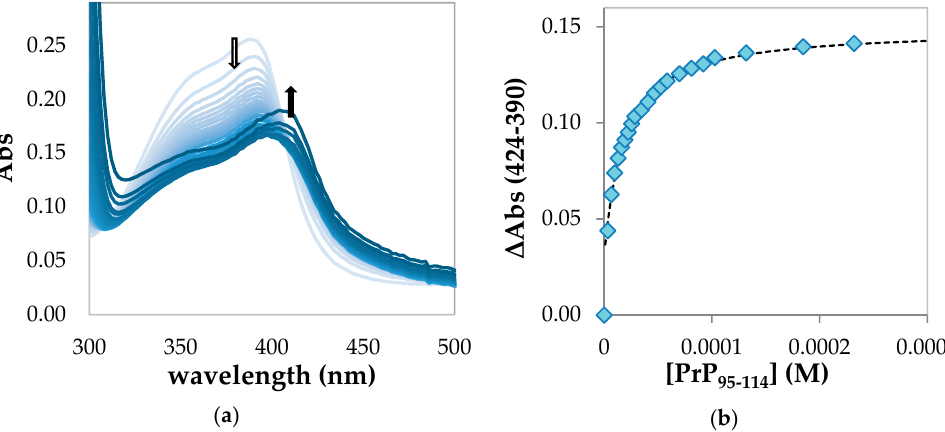
Figure 2. ( a ) UV–Vis spectrophotometric titration in 20 mM phosphate buffer solution, pH 7.4, showing the decrease in intensity of the Soret band upon binding of hemin (3.25 μ M) with PrP 95–114 (from 0 to 90 equiv., light blue to blue) in a cell of 1 cm path length. The arrow pointing down at 390 nm indicates the hypochromic effect due to the formation of a high-spin hemin-PrP complex; the arrow pointing up at 416 nm indicates the incipient formation of a low-spin complex; ( b ) absorbance changes with respect to free hemin at 424 nm with subtraction of the contribution at 390 nm vs. PrP 95–114 concentration fitted by high-affinity equation described in the Materials and Methods section. At larger peptide excess, absorption spectra show an increasing contribution by a band with maximum above 400 nm, which indicates the partial formation of a low-spin 1:2 hemin:peptide complex. However, the increase of the baseline over 450 nm and the absence of a clean isosbestic point indicate that a precipitation process is occurring.